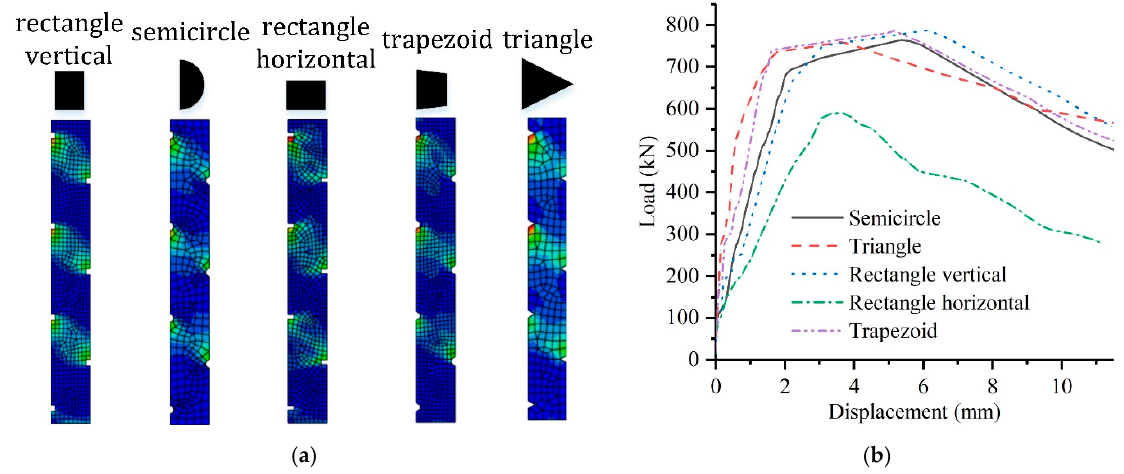
Figure 15. Different shear key shapes: ( a ) grouting strain of different shear key shapes; ( b ) comparison of load–displacement curves of different shear key shapes.